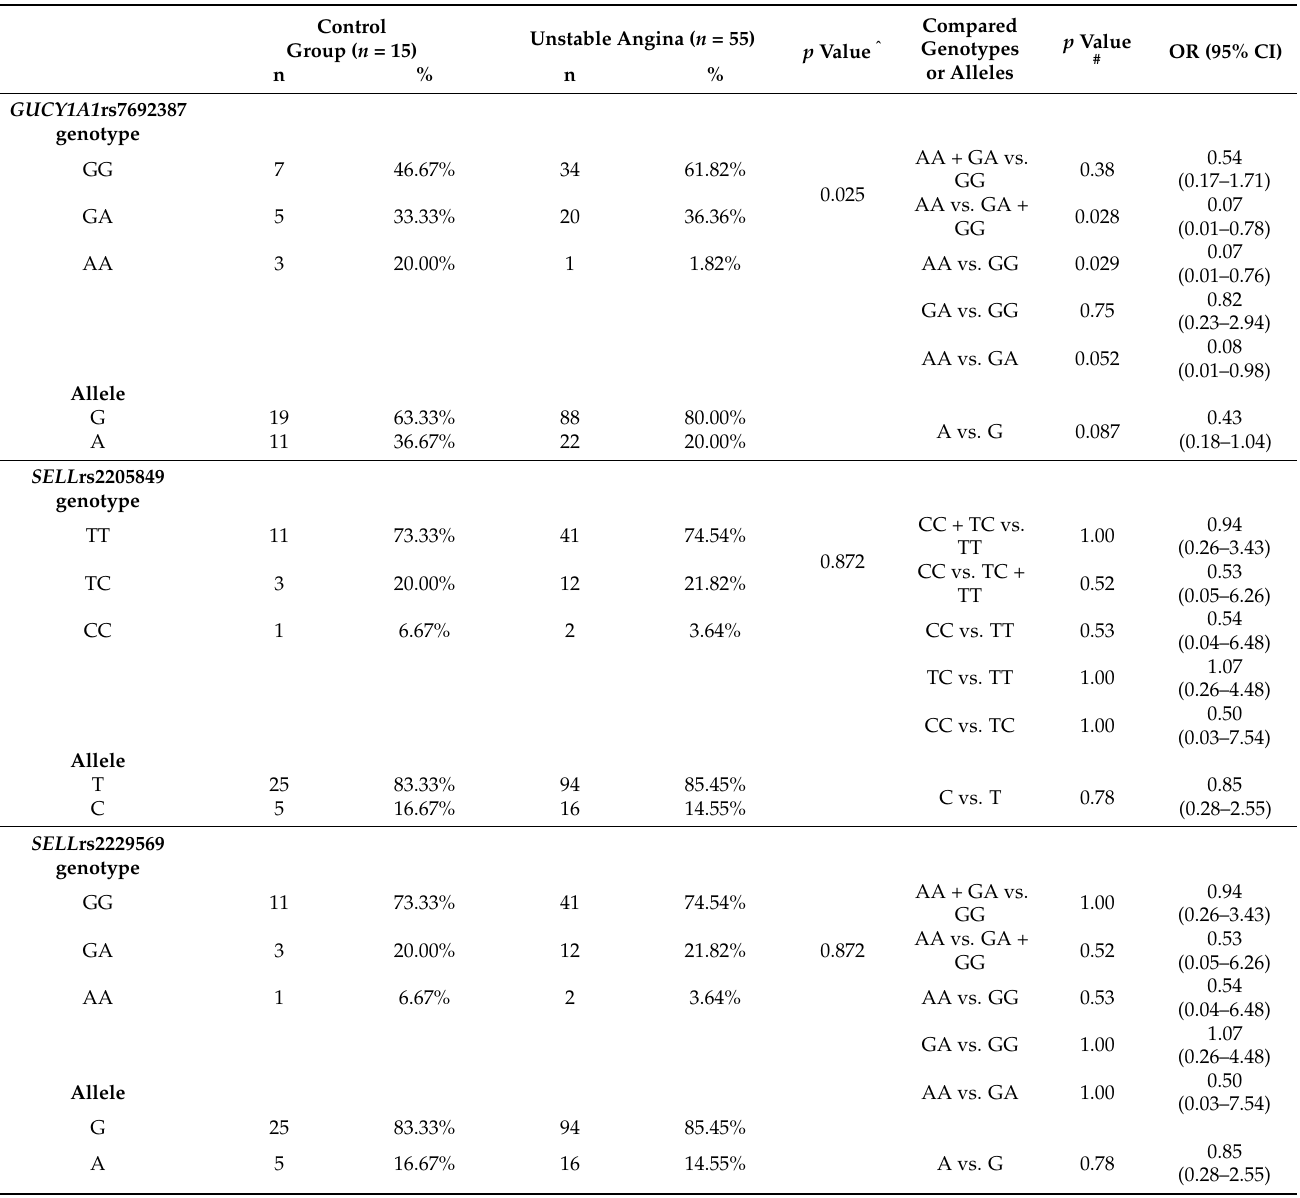
Table 3. Distribution of GUCY1A1 rs7692387, SELL rs2205849 and rs2229569 genotypes and alleles in UA patients and controls in the <55 years